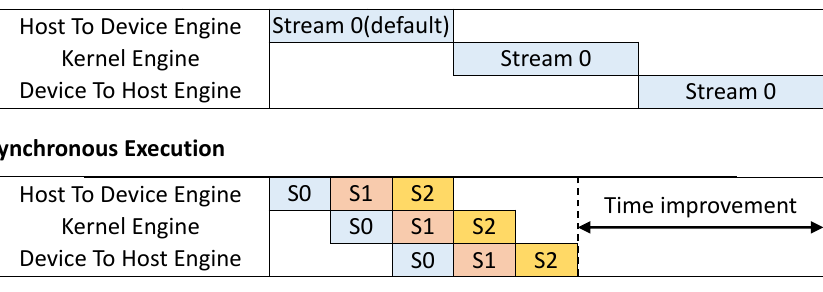
Figure 10. Asynchronous execution by using CUDA